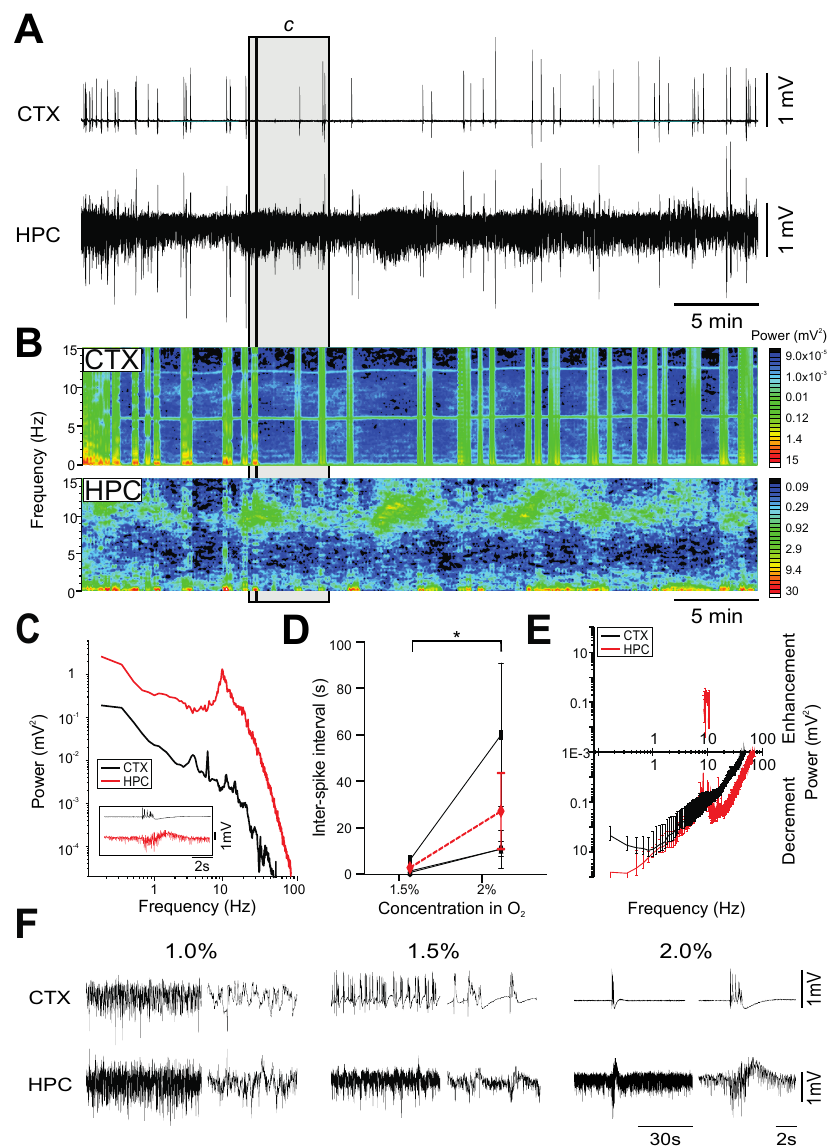
PTB, bursts tended to occur concomitantly at both the neocortical and hippocampal sites, while periods of isoelectricity in cortex corresponded to low-voltage fast activity (8–15 Hz; n = 5) in the hippocampus (Figure 4C).